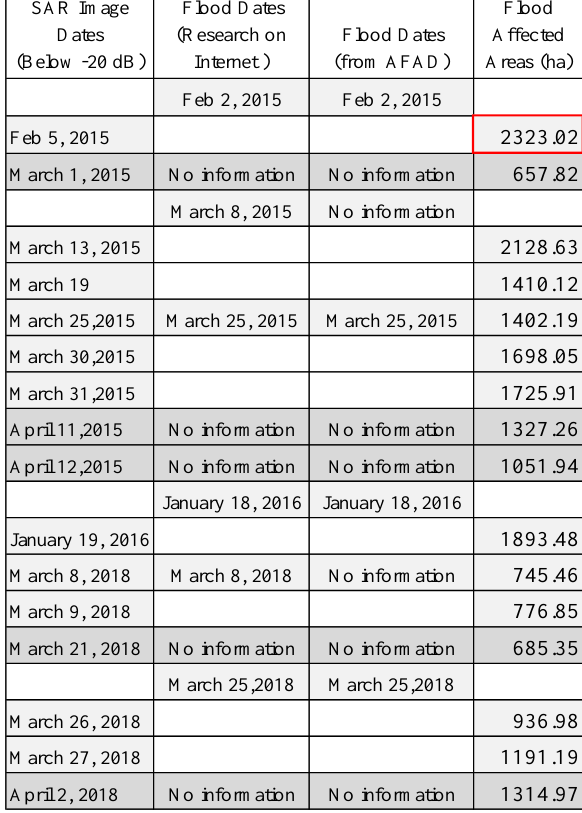
Table 2. Comparison of floods obtained from SAR images with digital media and AFAD data.